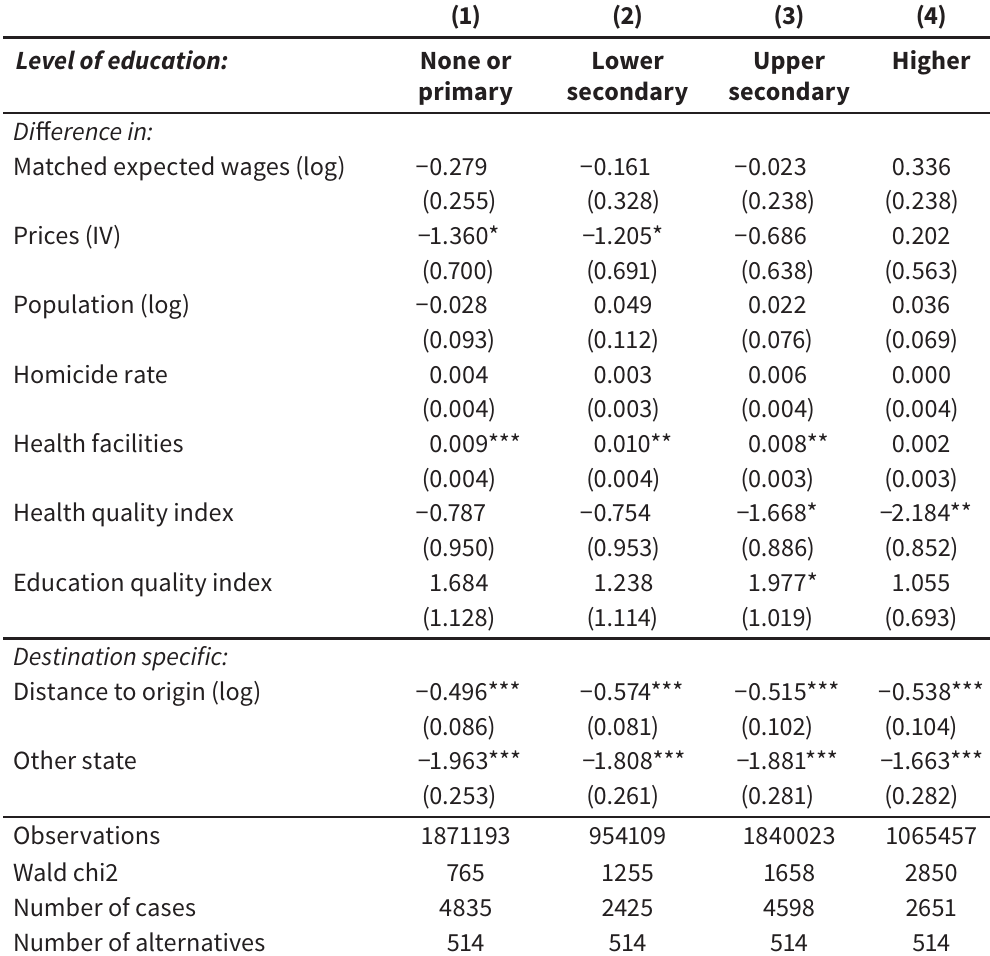
Destination choice conditional on migration by the education of migrant, alternative specific